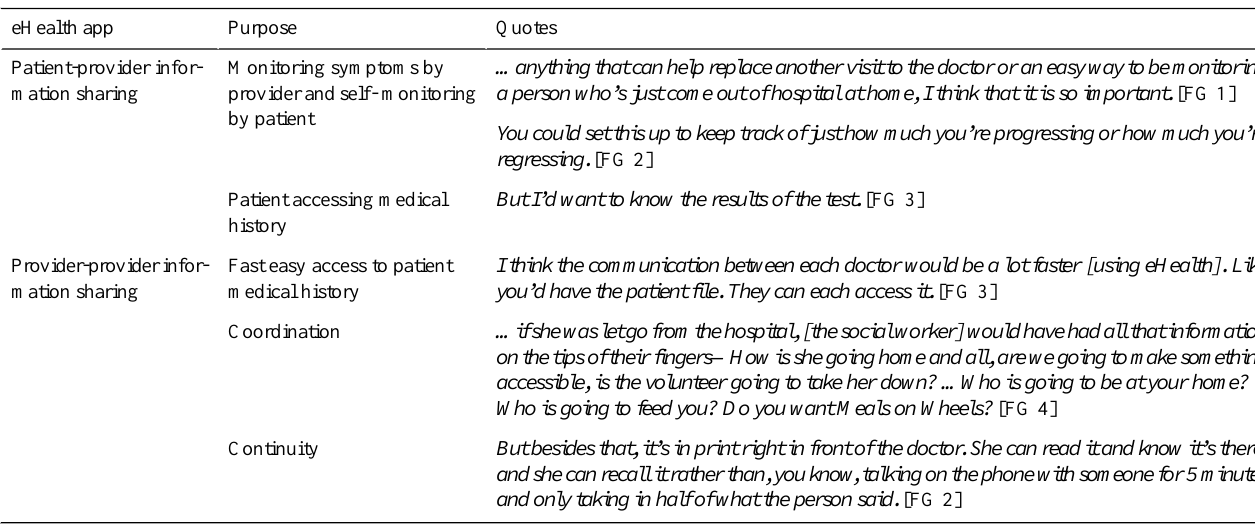
Table 1. Supporting our CCDD patient needs using eHealth